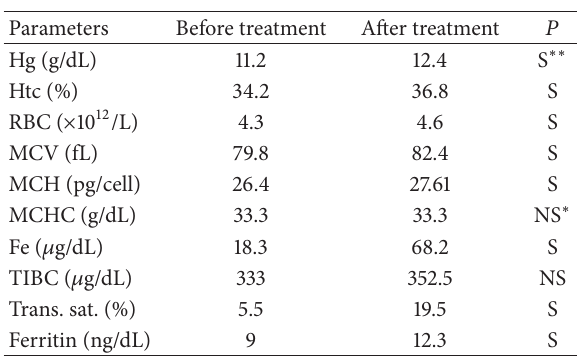
Table 2: (a) A general analysis of 54 patients receiving Fe +3 , 24 patients from the study, and the remaining 30 patients. (b) A general analysis of 50 patients receiving Fe +2 , 16 patients from the study, and the remaining 34 patients.